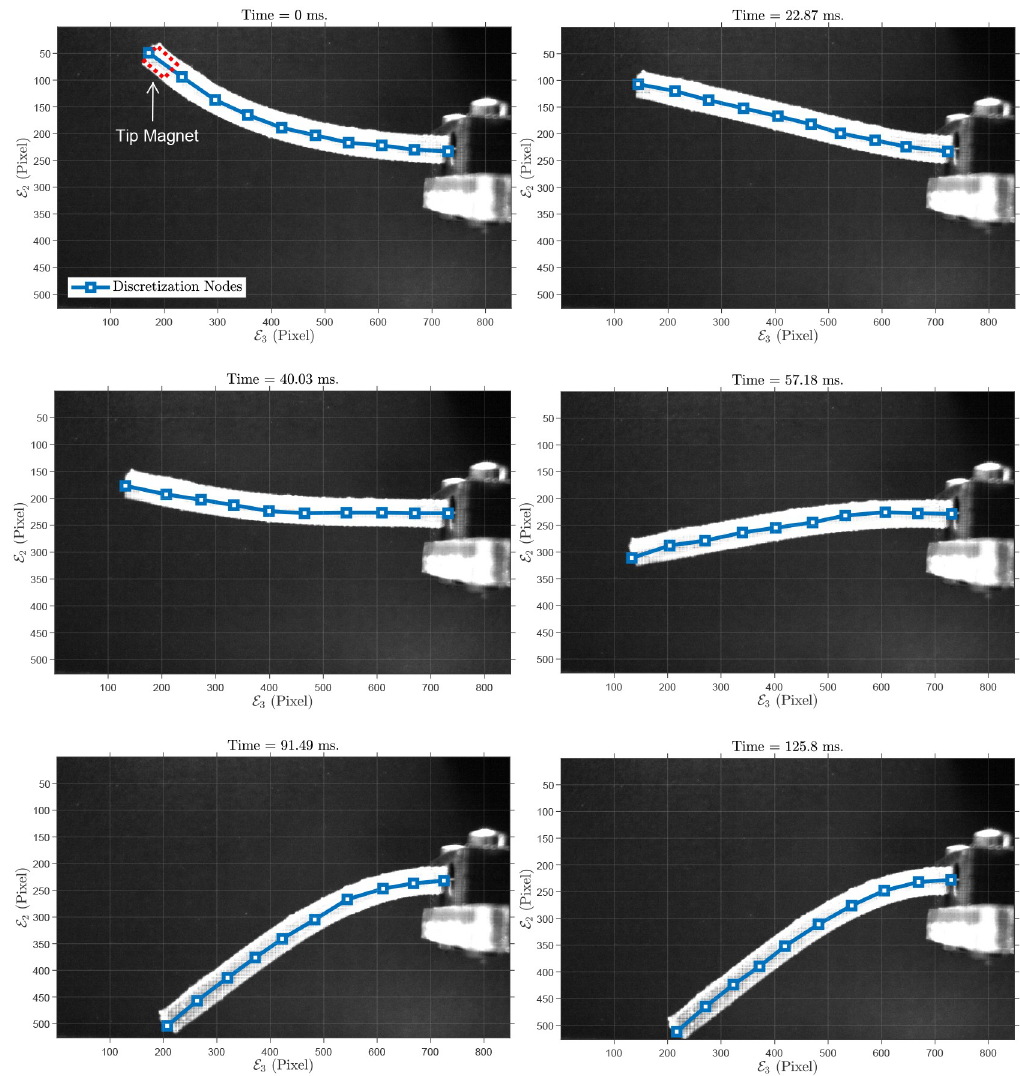
Fig 10. Sample of grabbed images: Polydimethylsiloxane (PDMS) rod with an embedded magnet at the tip in 2D experiment: Motion in a plane. Also, 10 discretization points are shown on the soft rod.